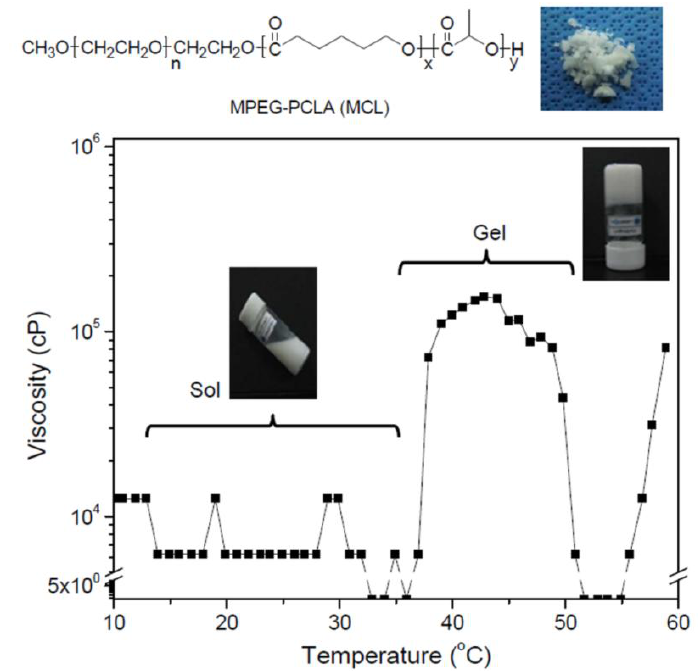
Figure 2. Relationships between the viscosity and temperature of the MCL solution at 20 wt %